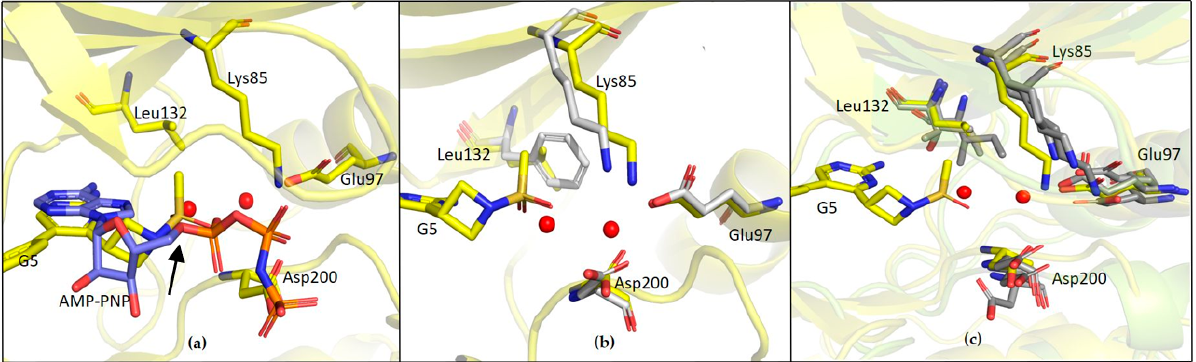
Figure 11. ( a ) Overlapped structure of GSK3 β -G5 complex with GSK3 β -AMP complex (PDB 1PYX); the black arrow indicates the first phosphate of AMP-PNP ( b ) Overlapped structure of GSK3 β -G5 with CDK9 structure (PDB 3BLQ); ( c ) Overlapped structure of GSK3 β -G5 with kinases showing inhibition with G5 (P70S6K/PDB 3A61, SAPK2a/PDB 1OZ1 and LOK1/PDB 6HXF). GSK3 β -G5 complex is in yellow and comparison structures are represented in grey.